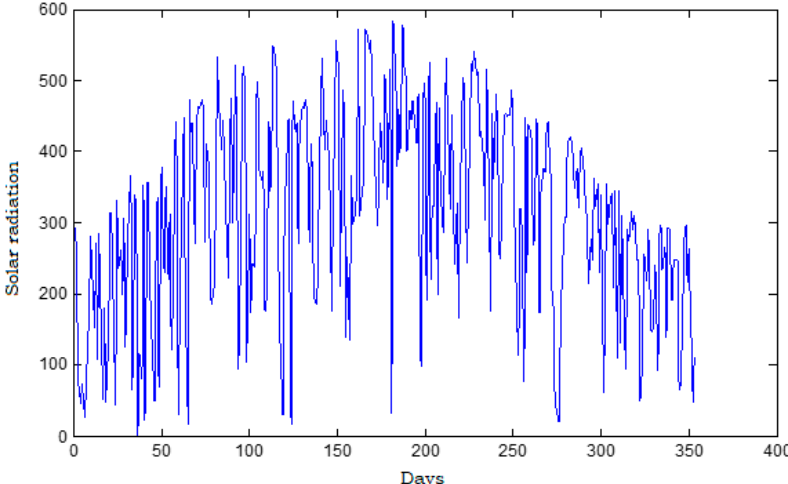
Figure 14. Solar radiation evolution along a year (daily radiation averages).